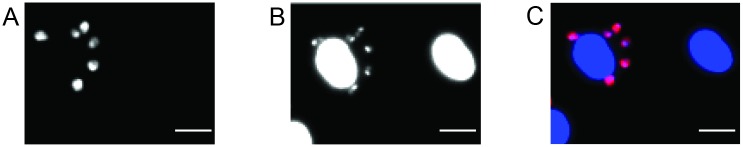
Intracellular L. infantum labeled with anti-parasite antibodies by IFAT and with DAPI.Leishmania infantum-infected BMDM stained with (A) anti-cTXNPx and anti-mTXNPx and with (B) DAPI (arrows identify intracellular parasites). (C) Merged image showing co-localization of DAPI-stained (blue) parasites with antibody labeling (red). Images were acquired with an IN Cell Analyzer 2000 microscope. Scale bar, 10μm.